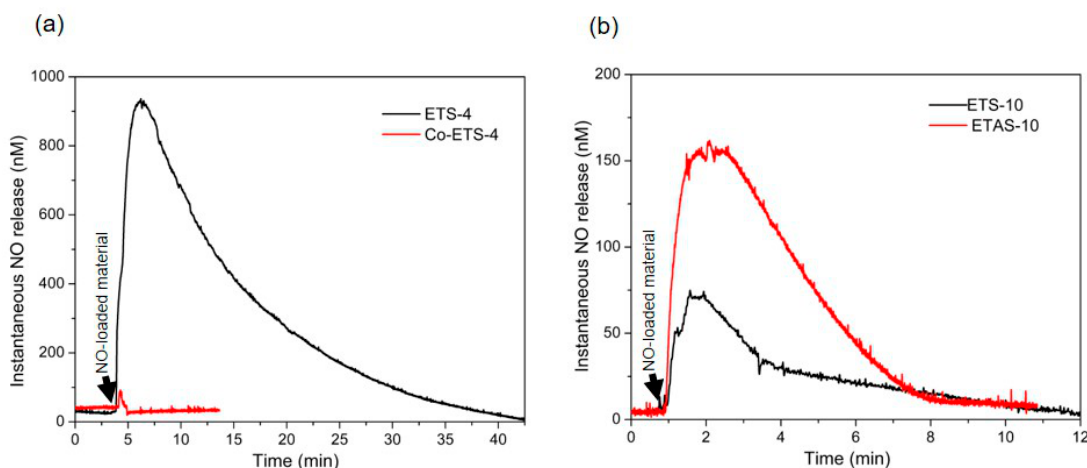
Figure 5. Nitric oxide release profiles from NO-loaded titanosilicates obtained by a direct measurement with NO electrochemical sensor. ( a ) Release profiles of ETS-4 and Co-ETS-4 obtained in supplemented RPMI-1640 medium at room temperature using a materials concentration of 450 µ g mL − 1 ; ( b ) release profiles of ETS-10 and ETAS-10 obtained in the same conditions as ( a ) but using a di ff erent material’s concentration (900 µ g mL − 1 ).